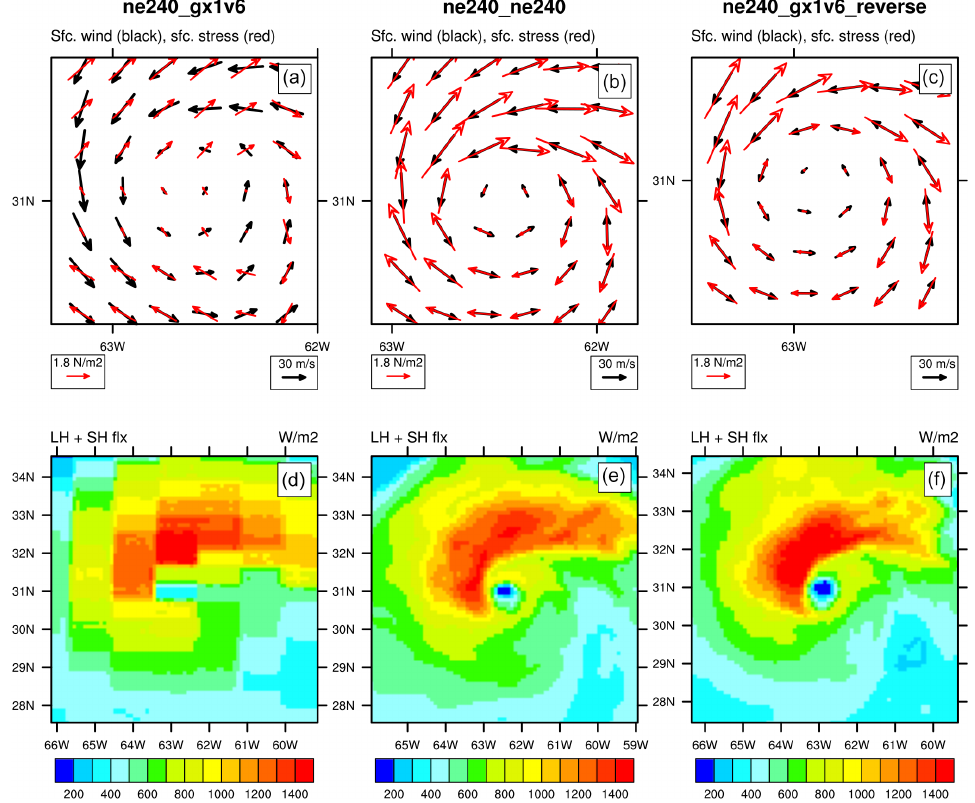
Figure 5. 120h CAM-SE forecast for Hurricane Leslie, valid at 00Z on 5 September 2012. Left panels (a, d) are results from forecast using 1 ◦ ocean grid in the default configuration (calculations of momentum drag and surface fluxes are carried out on the ocean grid). Center panels (b, e) show results using 0.125 ◦ ocean grid. Right panels (c, f) show version of 1 ◦ ocean grid where calculations are instead carried out on the finer atmospheric grid. Top panels (a–c) display instantaneous wind in the lowest model (black vectors) with corresponding lowest model level wind stress (red vectors). Lower panels (d–f) show total surface flux (latent plus sensible